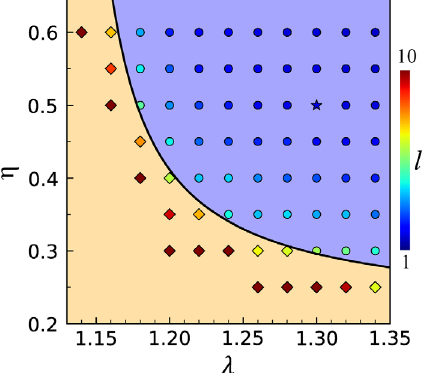
FIG. 7. The finest mean grain diameter l for systems with different η ’ s and λ ’ s. ð η − 0 . 193 Þð δ − 0 . 214 Þ ¼ 0 . 02 (solid curve) separates the blue region exhibiting a polycrystal-glass transition (circles) and the orange region exhibiting no polycrystal-glass transition (diamonds). The star represents the system used in Figs. 1 – 6.